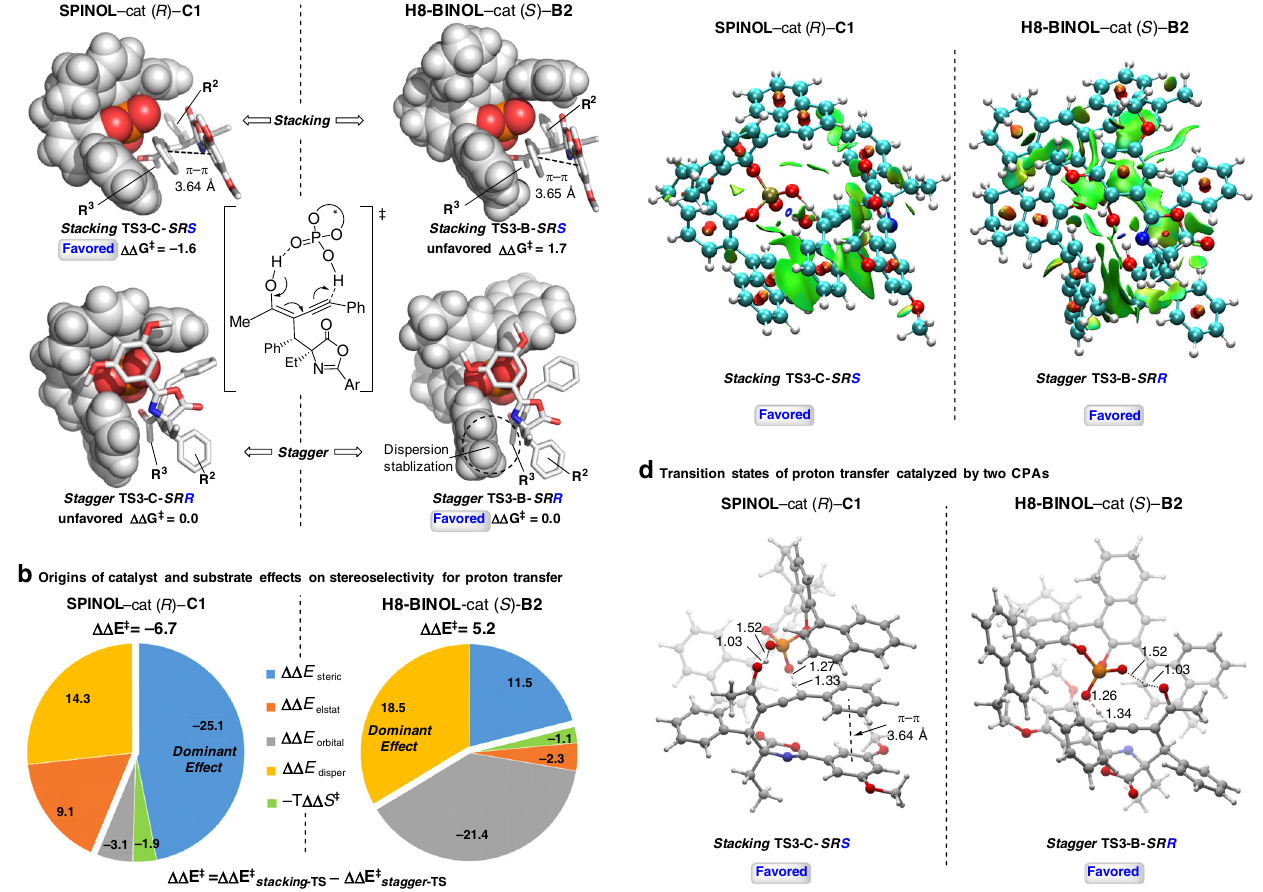
Fig. 5 Computational studies on origin of diastereoselectivity. Comparison two types of interaction modes between CPA ( R )- C1 /( S )- B2 and substrates. a Space- fi lling model of stacking -TS versus stagger -TS for proton transfer. b Energy Decomposition Analysis (EDA) of transition states for proton transfer at B3LYP-D3/TZ2P level of theory by using ETS-NOCV in ADF. The relative energy ( ΔΔ E ‡ ) is the sum of ΔΔ E 0 ‡ and (-T ΔΔ S ‡ ), where the entropy term is from Gaussian calculations. For the energy decomposition analysis equation follows: ΔΔ E 0 ‡ = ΔΔ E steric + ΔΔ E elstat + ΔΔ E orbital + ΔΔ E disper . The ΔΔ E ‡ is calculated from the electronic energy difference between stacking -type TS and stagger -type TS ( ΔΔ E ‡ = Δ E stacking -TS ‡ − Δ E stagger -TS ‡ ). Each energy component ( ΔΔ E steric , ΔΔ E ΔΔ E ΔΔ E ΔΔ E values indicate corresponding interactions promote stagger -type, and R -axial elstat , orbital , and disper ) is calculated in the same fashion. Positive chirality TS is more favored. In contrast, negative ΔΔ E values indicate S -axial chirality TS with stacking -type is more stable; E steric is the positive term as the steric repulsion, and E disper is the negative term as the dispersion stabilization. c Noncovalent Interactions (NCIs) analysis of transition state for proton transfer (green, dispersion effect; red, steric effect). The gradient isosurfaces ( s = 0.3 a.u.) are colored on an BGR scale according to sign( λ 2 ) ρ over the range − 0.01 to 0.01 au. d Detailed structural information of proton transfer transition states catalyzed by two CPAs. The energies shown in kcal/mol.